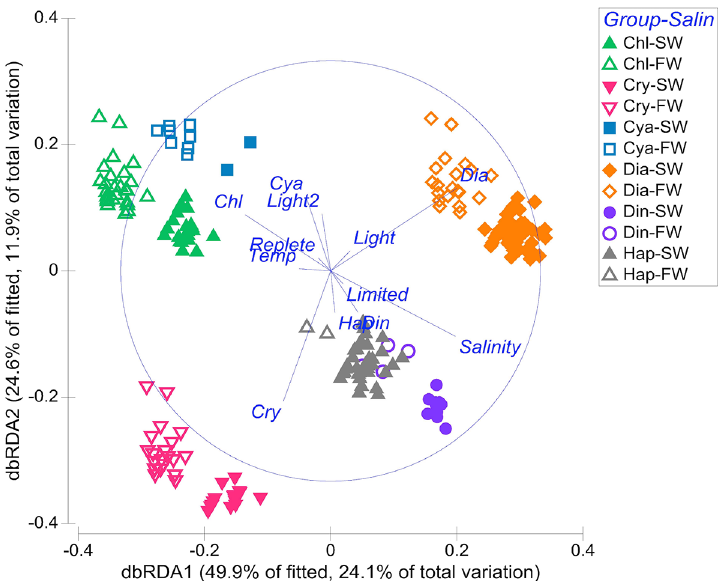
Fig 1. Distance-based redundancy analysis (dbRDA) ordination of the full multivariate ISTLM. The DISTLM partitioned the variance in phytoplankton fatty acids explained by the predictor variables for all 621 phytoplankton % FA profiles for which all culture conditions were available [follows Table 1 variable descriptions except salinity here is coded as freshwater (FW) or saline water (SW) for visualization)]. The group abbreviations are: Chl (Chlorophyta); Cry (Cryptophyta); Cya (Cyanobacteria); Dia [diatoms (Bacillariophyceae, Coscinodiscophyceae, Fragilariophyceae)]; Din (Dinophyta); and Hap (Haptophyta). The first two axes explained 75% of the variability in the fitted model. The top two ranked variables in the model for this dataset, group and salinity, are identified with the symbols. Vector overlays show the strength of the relationship between the predictor variables and the dbRDA